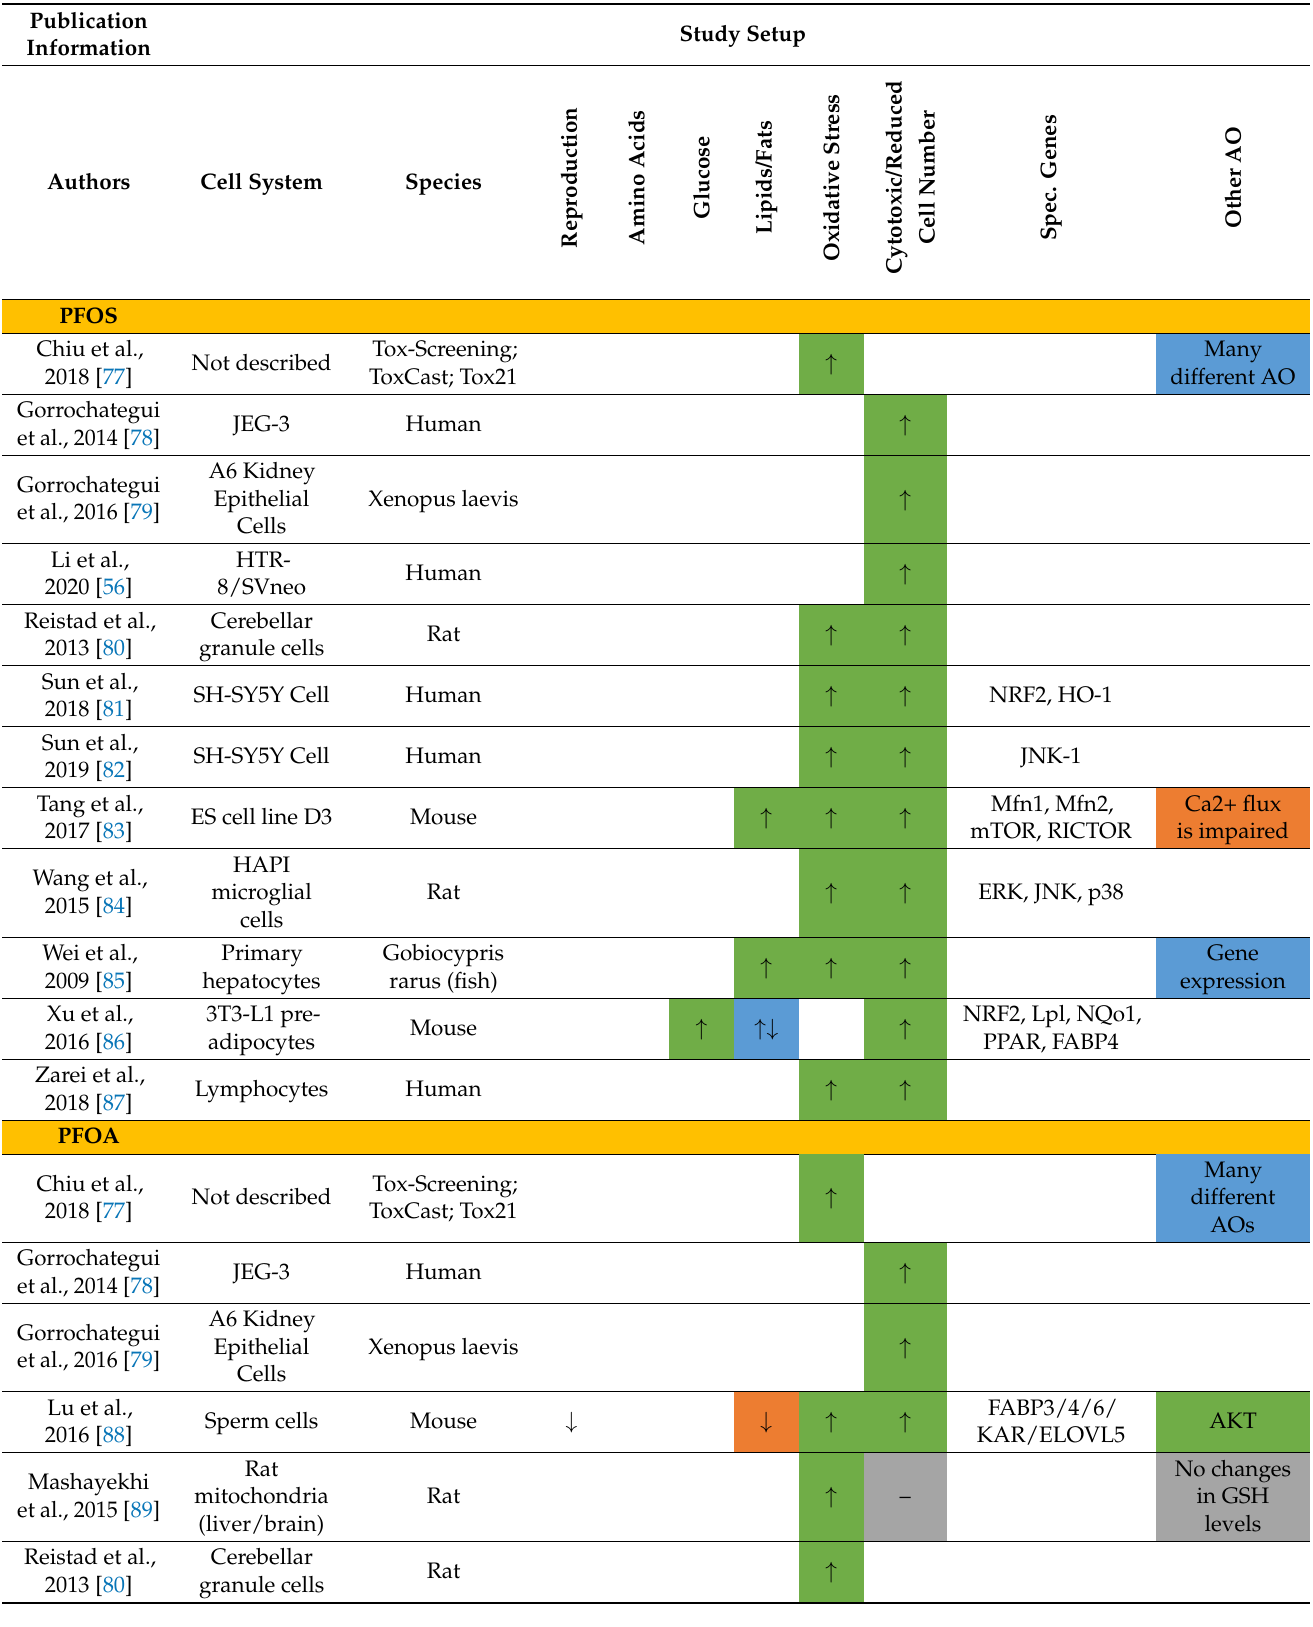
Table 5. In vitro results related to PFAS-induced oxidative stress and reduced cellular